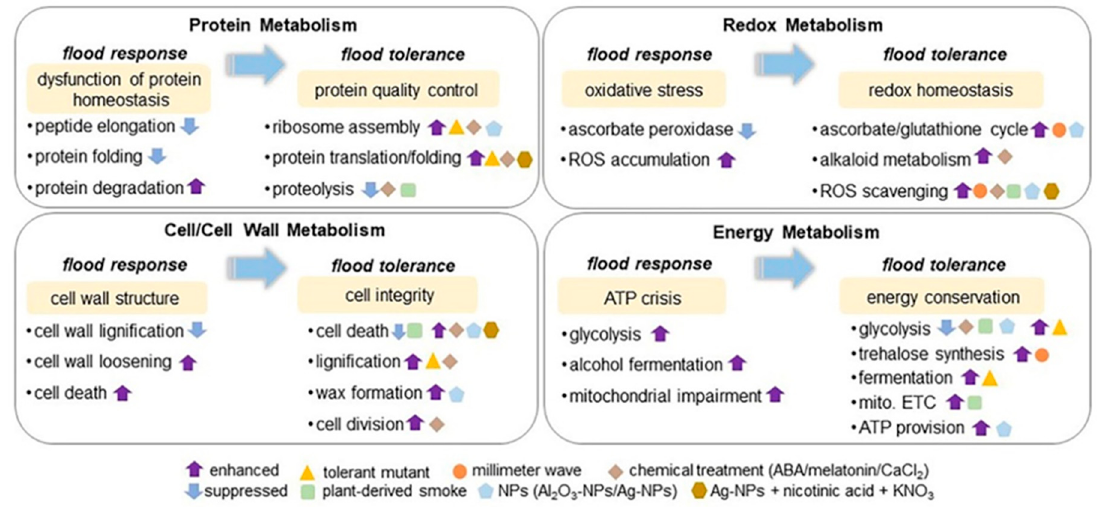
Figure 2. Soybean proteomics in understanding signaling mechanisms under flooding stress. The presented schemes of core-signaling mechanisms, including protein metabolism, redox metabolism, cell/cell-wall metabolism, and energy metabolism, involved in stress response and tolerance in the early-stage soybean under flooding stress was summarized based on proteomic studies. The signaling mechanism of flooding tolerance was constructed from proteomic data collected from soybean plants with flood-tolerant characteristics. The metabolisms highlighted with yellow color mean induced events for stress response and tolerance in flooded soybean. The upward and downward arrows mean enhanced and suppressed metabolisms. Triangle indicates flood-tolerance-mutant of soybean developed from gamma irradiation. Circle, diamond, square, pentagon, and hexagon indicate the treatment of millimeter-wave irradiation, chemical application (abscisic acid, melatonin, and CaCl 2 ), plant-derived smoke, nanoparticles (NPs), and Ag-NPs with nicotinic acid and KNO 3 , respectively, alone with flooding stress. ABA stands for abscisic acid; mito. ETC stands for mitochondrial electron transport chain; and ROS stands for reactive oxygen species.